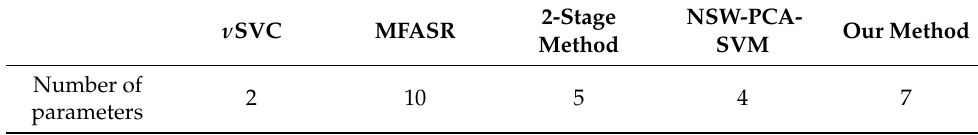
Table 4. The number of parameters in different methods.